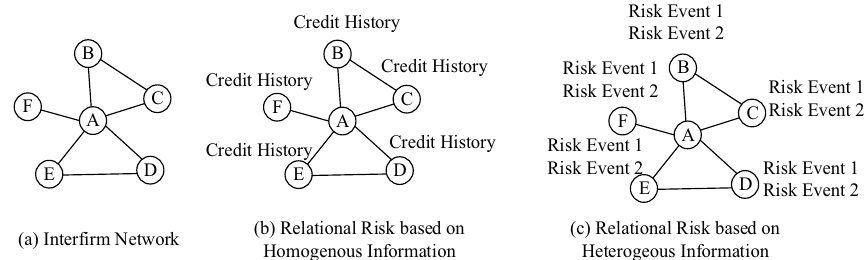
Fig. 1 Interfirm network and relational risk. a shows an example of an inter-firm network, in which node A represents a target firm, and nodes B–F represent neighbor firms of A. b and c show how to quantify A’s relational risk using credit histories of neighbor firms and risk events of neighbor firms,